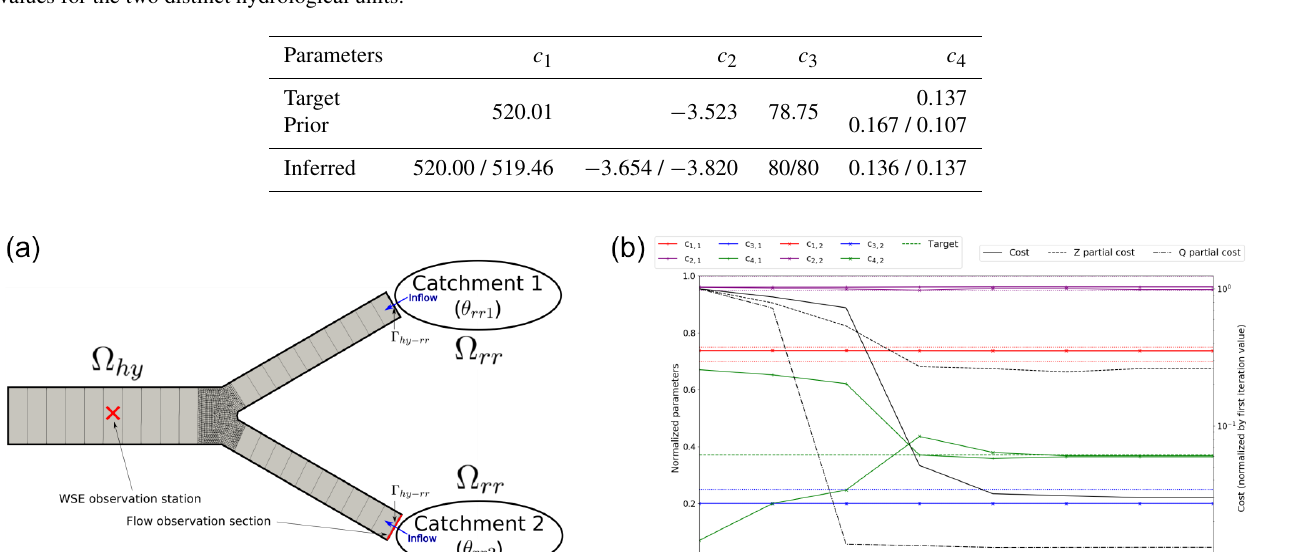
Table 2. Hydrological parameter inference results. Prior values are taken as identical to target values, except for parameter c 4 , where under- and overestimated prior value are considered. Inferred values for all parameters including c 4 are very close to the target. The “/” separates values for the two distinct hydrological units.